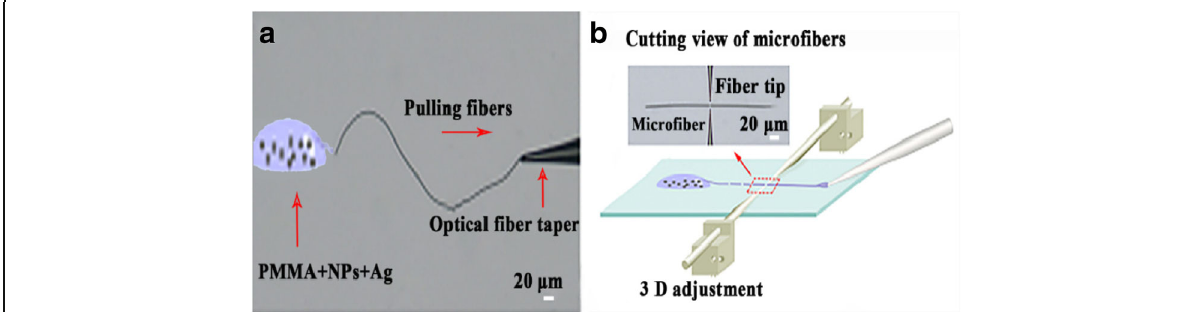
Fig. 1 Fabrication process of Ag co-doped microfibers ( a ) Pulling of microfibers from PMMA+NPs+Ag solutions. b Cutting view of fabricated microfibers into small pieces